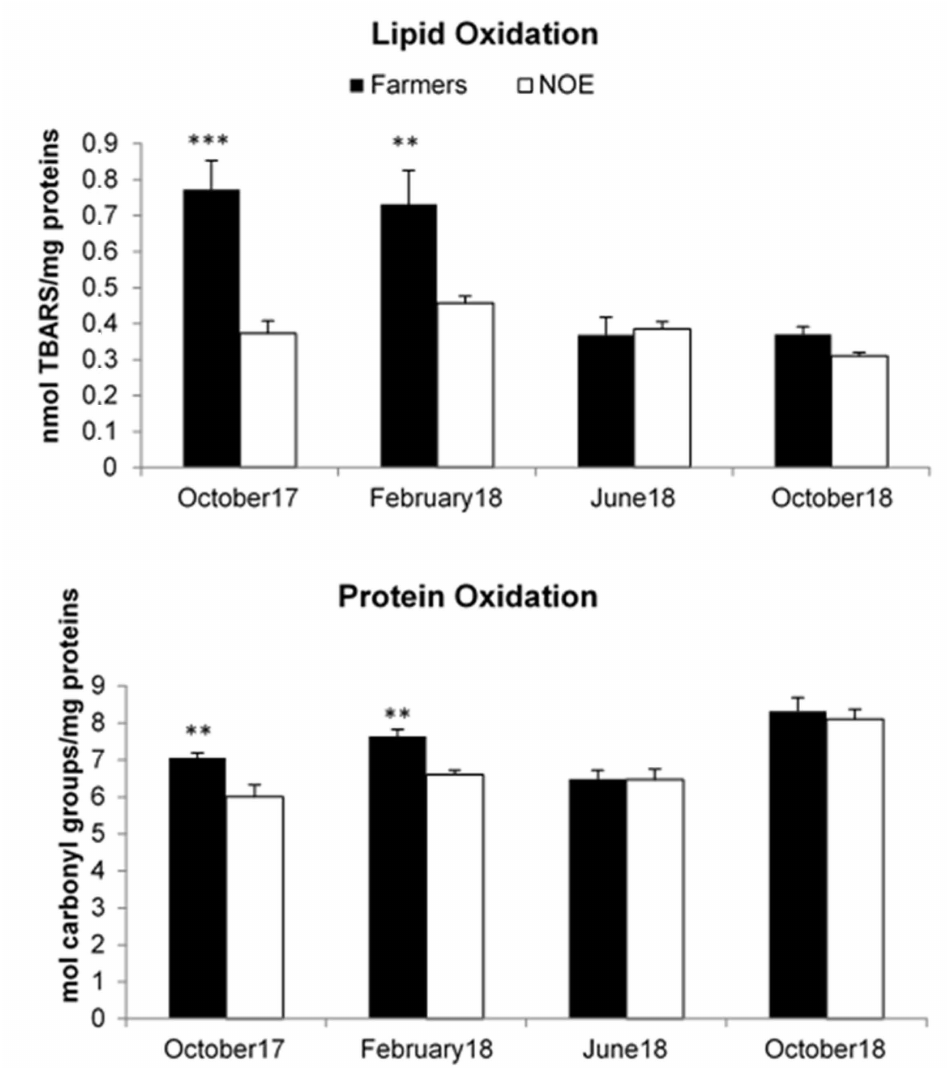
Figure 2. Activity of the biomarkers of oxidative stress at different sampling times. Data are expressed as the mean ± SEM; ** p < 0.01; *** p < 0.001 versus NOE group. NOE: non-occupational